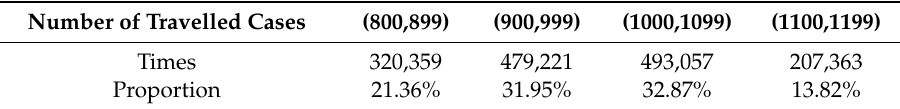
Table 9. The number of travelled cases for 1.5 million